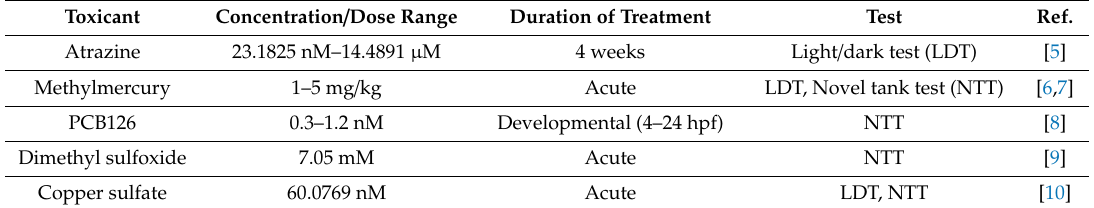
Table 3. Examples of toxicants that a ff ect anxiety-like behavior in zebrafish behavioral bioassays. Concentrations have been standardized to molarity to facilitate comparisons.